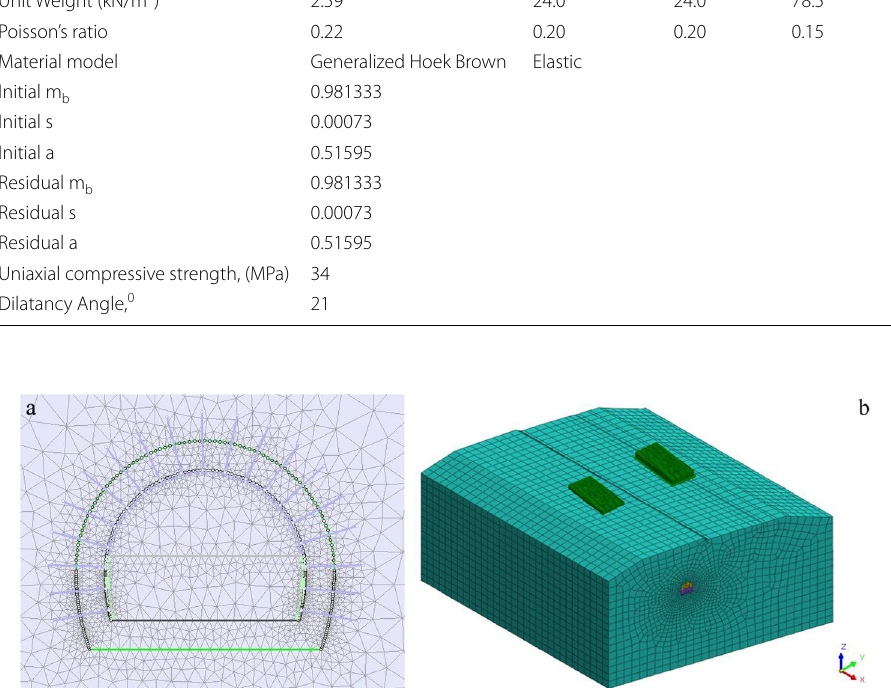
Fig. 14 Numerical mesh model for T5-1 Tunnel and Osmangazi approach viaduct interaction ( a : 2D model (Rocscience Phase 2D V8.2), b : 3D model (Midas GTS NX) were performed by Emre Ozcan Engineering